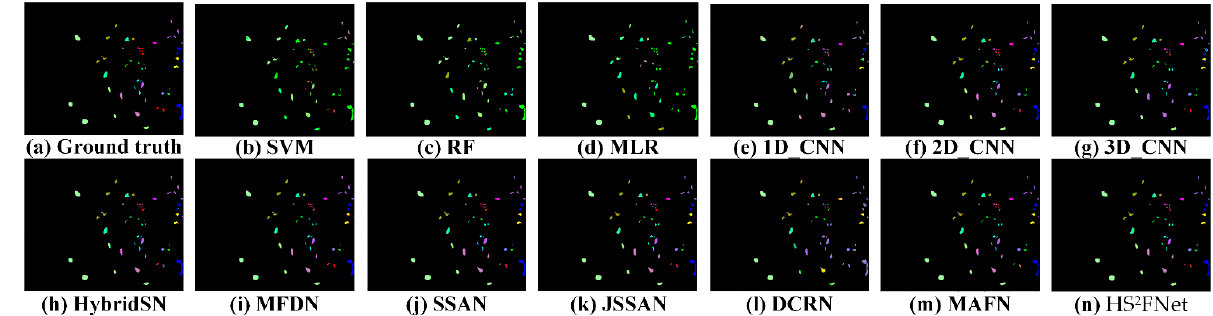
Figure 10. The visual comparisons of the state-of-the-art models and our network on UP dataset.